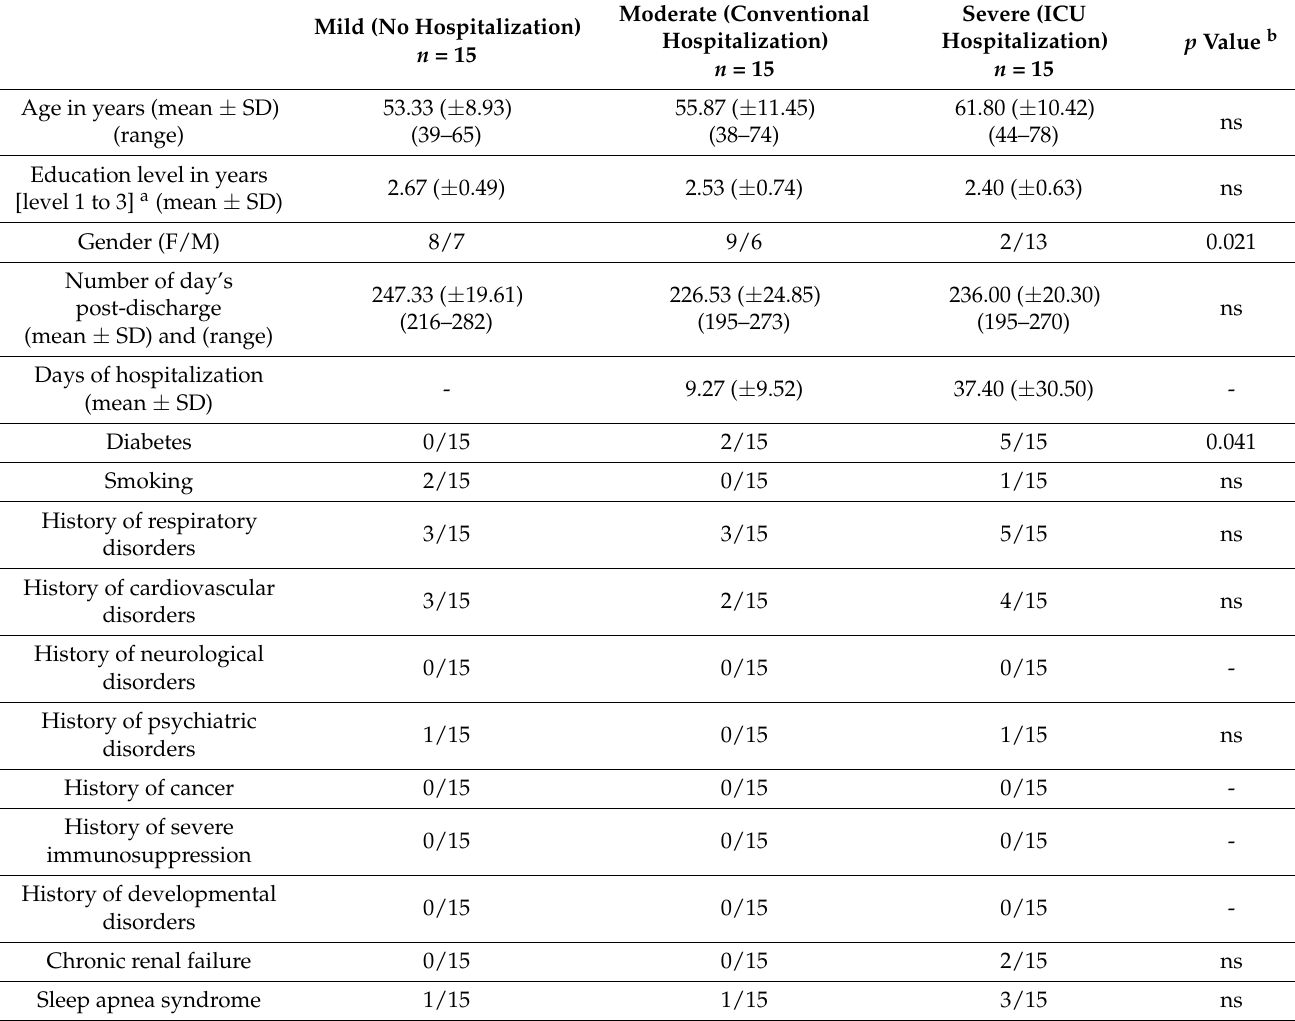
Table 1. Sociodemographic data and relevant medical